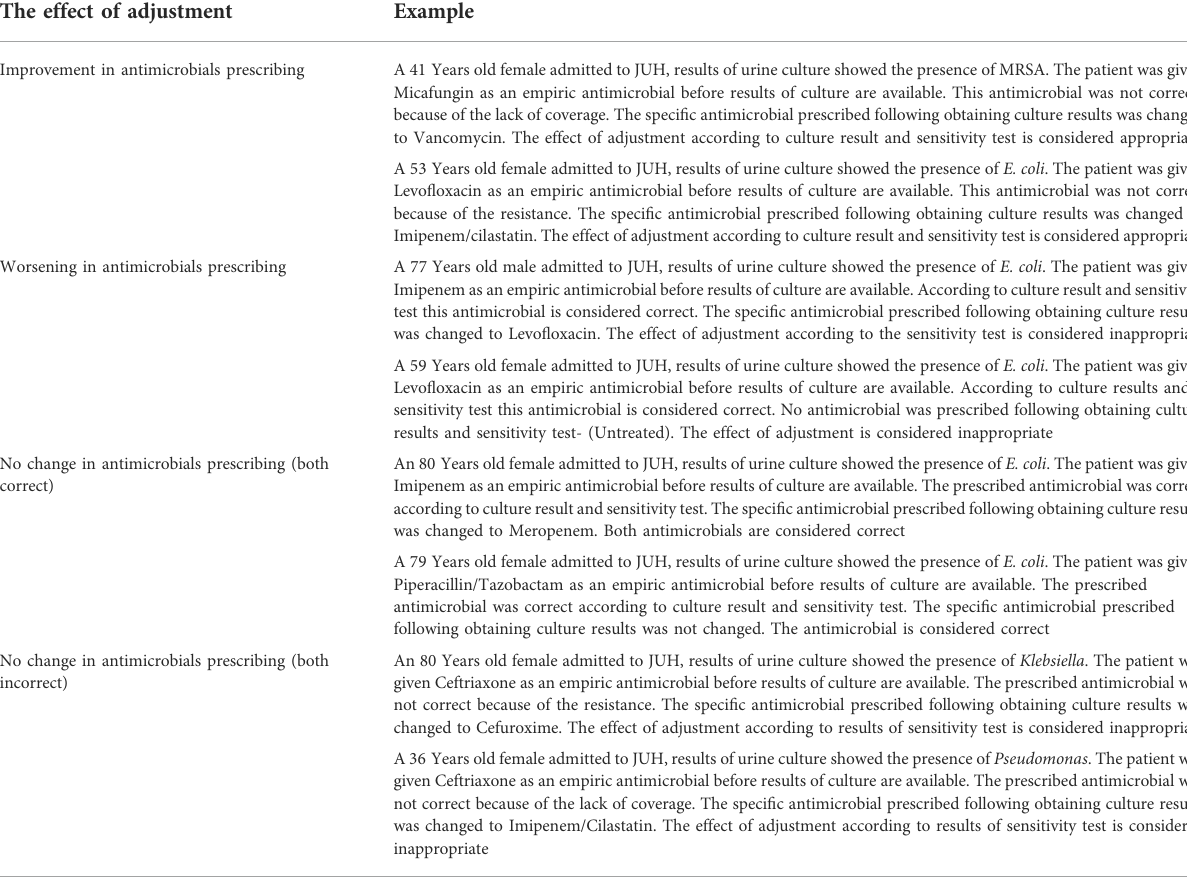
TABLE 2 Examples of the effect of antimicrobial adjustment following culture and sensitivity